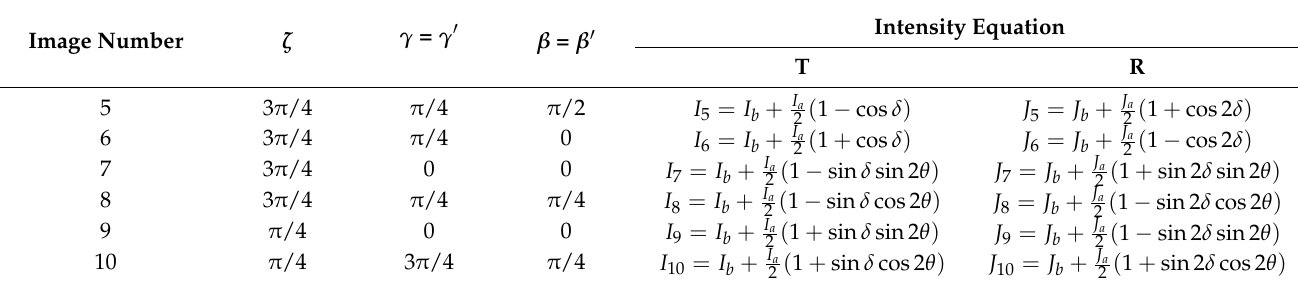
Table 2. The intensity equations in the circular